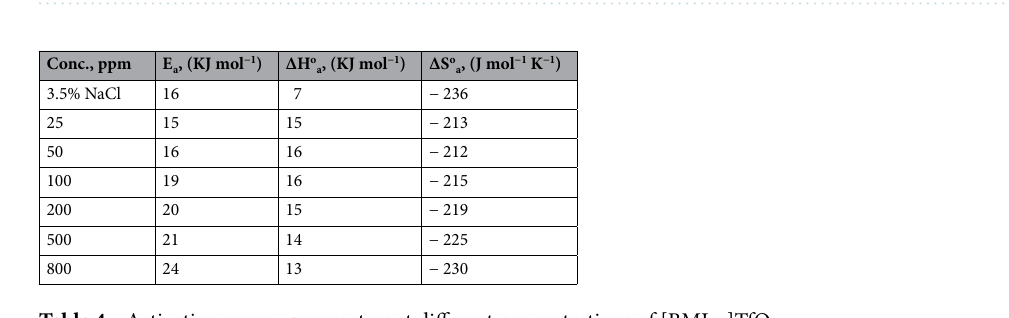
Table 4. Activation energy parameters at different concentrations of [BMIm]TfO.